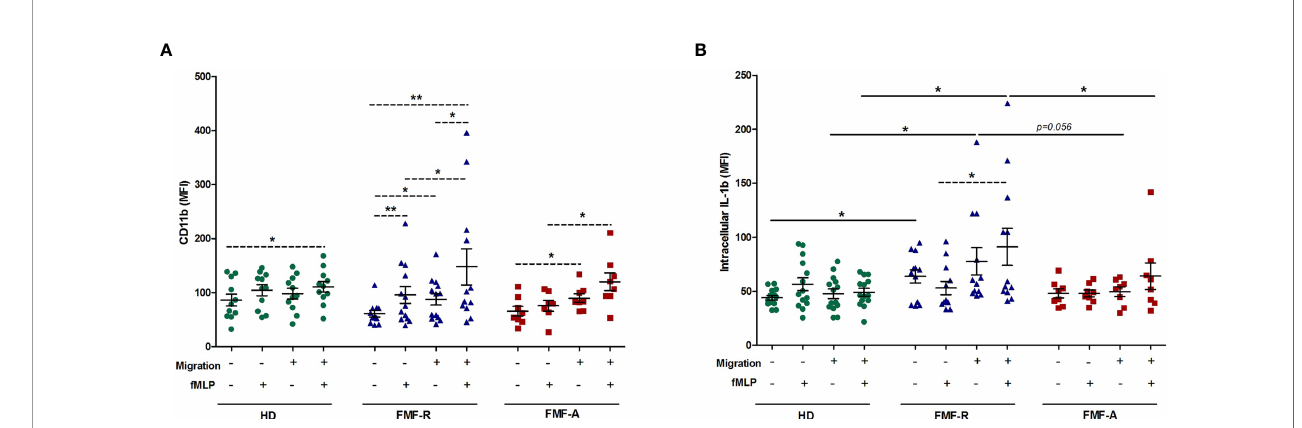
FIGURE 5 | Activation patterns of migrated and non-migrated PMNs. PMNs were allowed to transmigrate through 3- m m pore Polyester Membrane Inserts or cultured in 24-well plates (non-migrated control cells) for 2h in absence or presence of fMLP. (A) Surface expression of CD11b (MFI), and (B) Intracellular expression of IL-1 b (MFI), analysed by fl ow cytometry. * p < 0.05; ** p <